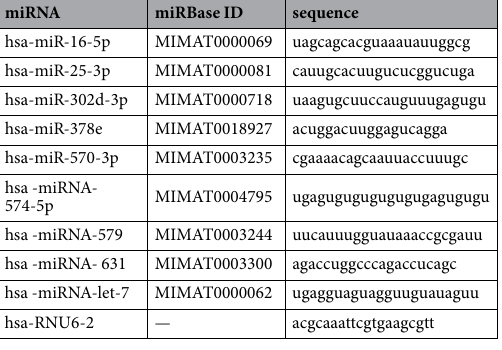
bated for 48 h at 37 °C.